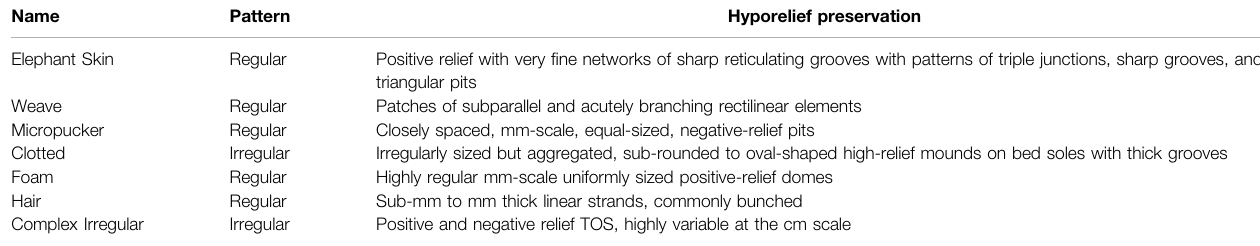
TABLE 3 | Common types of textured organic